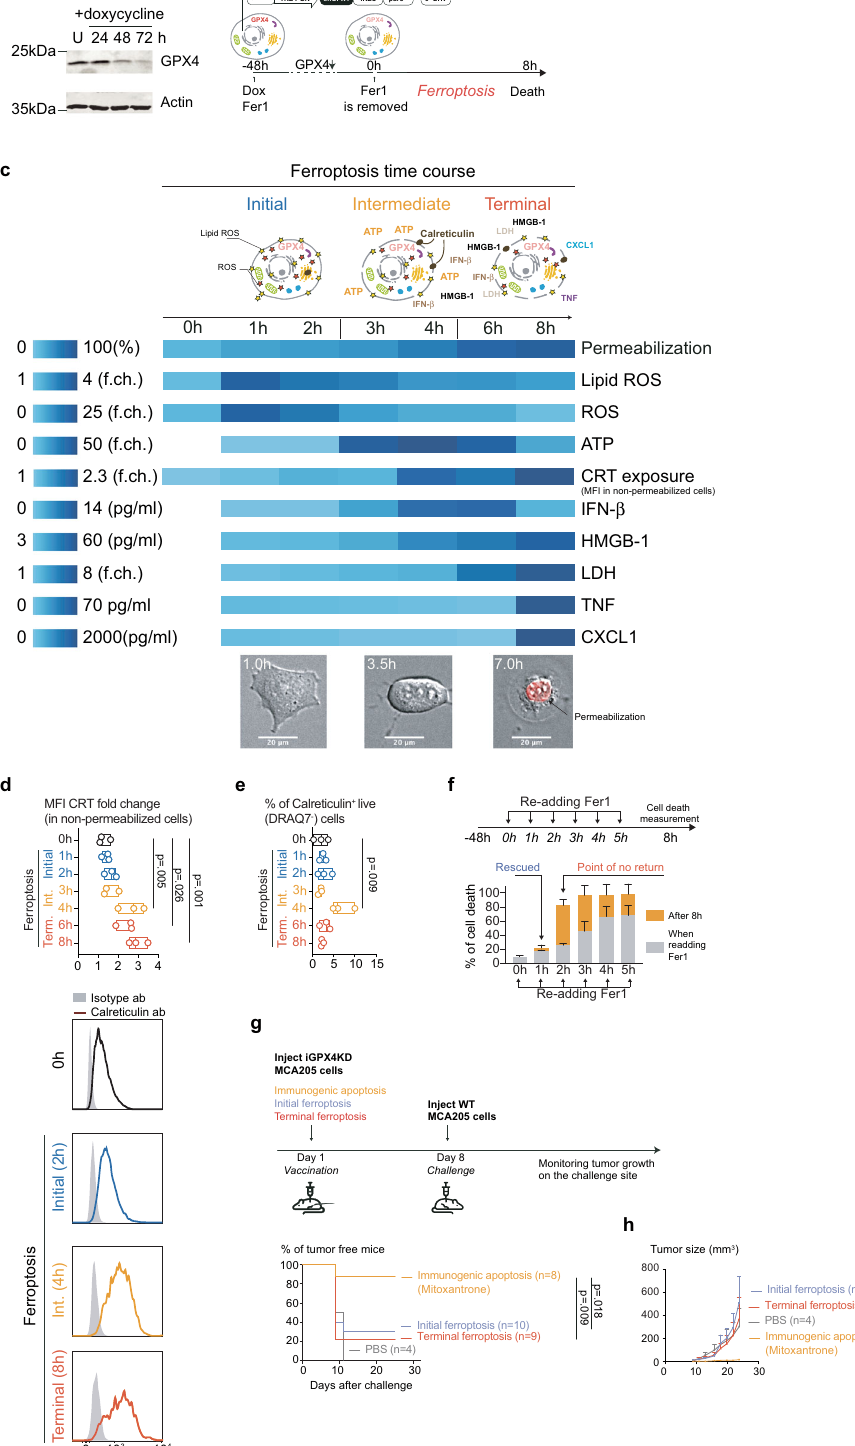
previously linked to the attraction of T cells to the tumor bed 36 . BMDC carrying a ferroptotic cargo strongly upregulated the expression of IFN- β and TNF, both of which positively correlate with the induction of immunogenicity 37,38 . An unbiased global pathway analysis (GSEA) revealed a picture that ferroptotic cells negatively regulated genes involved in the induction of T-cell NATURE COMMUNICATIONS| (2022) 13:3676